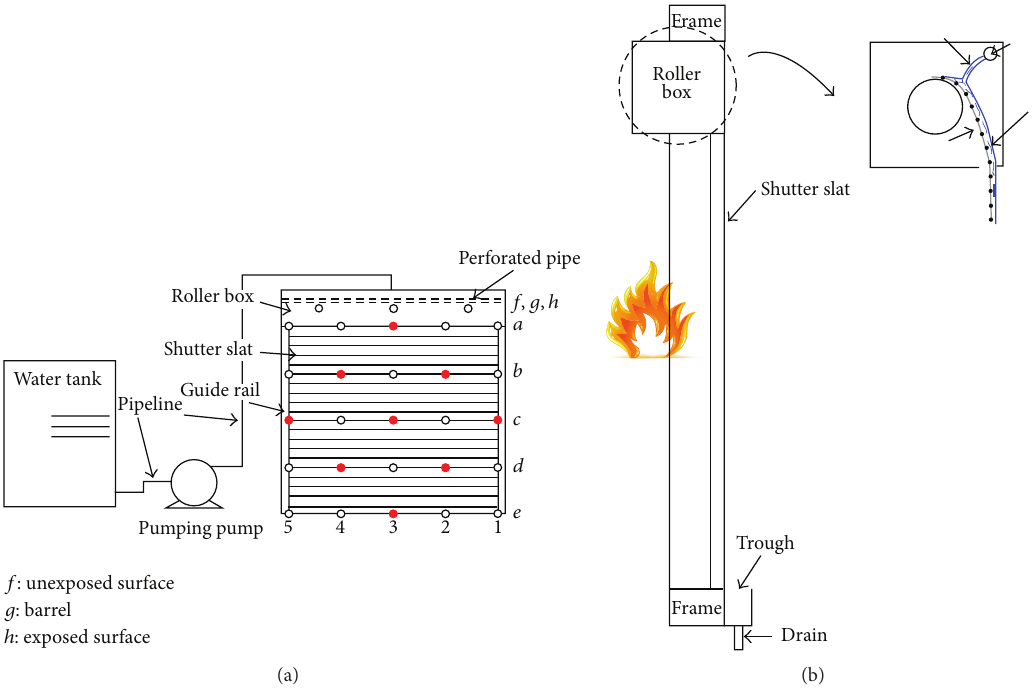
Figure 2: (a) Test frame with roller shutter and temperature measurement positions on the roller shutter; (b) schematic of the unexposed surface in a fire